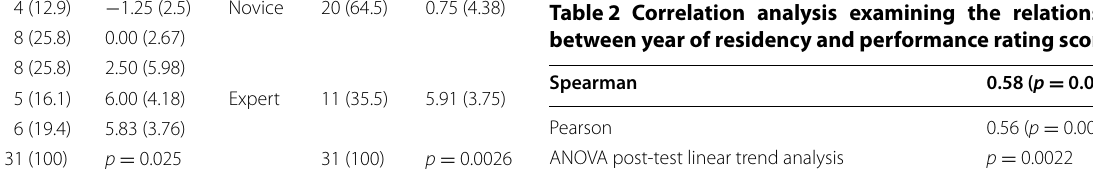
Table 2 Correlation analysis examining the